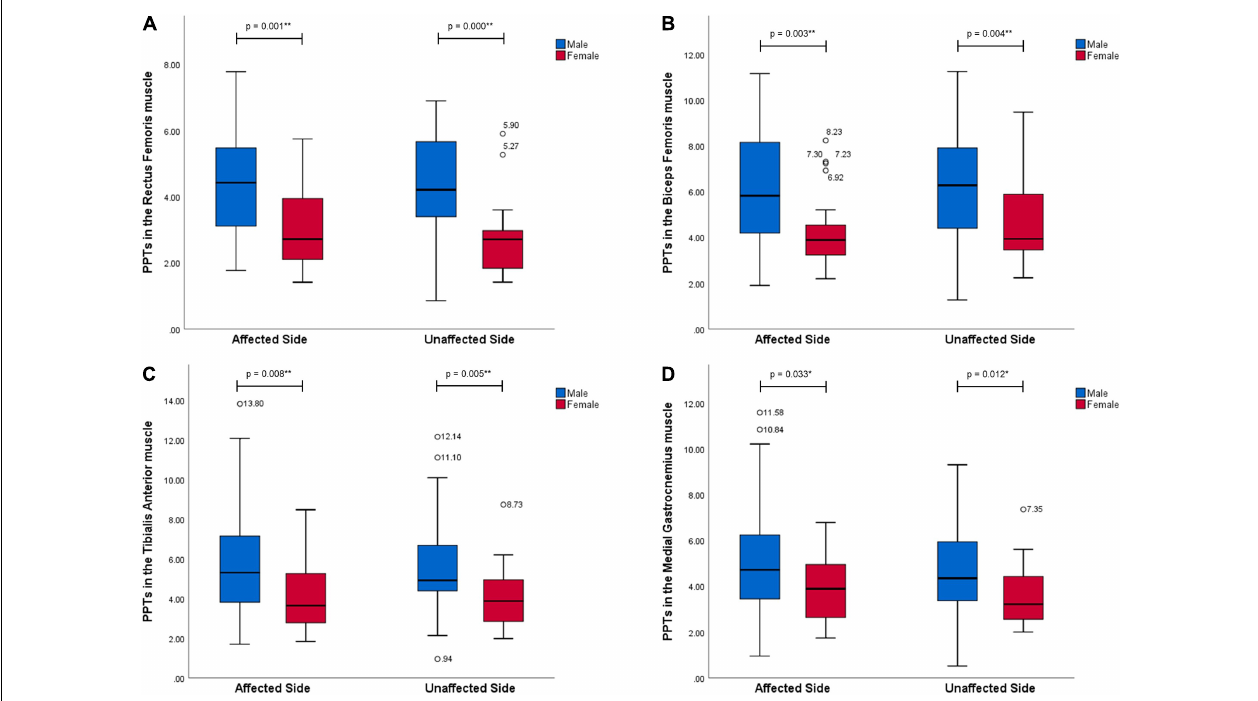
FIGURE 2 | Gender differences in PPT values in the muscles in the lower extremities (kgf). All muscles, RF (A) , BF (B) , TA (C) , and MG (D) , at both sides performed significantly higher pressure pain thresholds in men than women with stroke ( p < 0.05). * Representing a statistically significant difference with p < 0.05; ** representing a statistically significant difference with p <